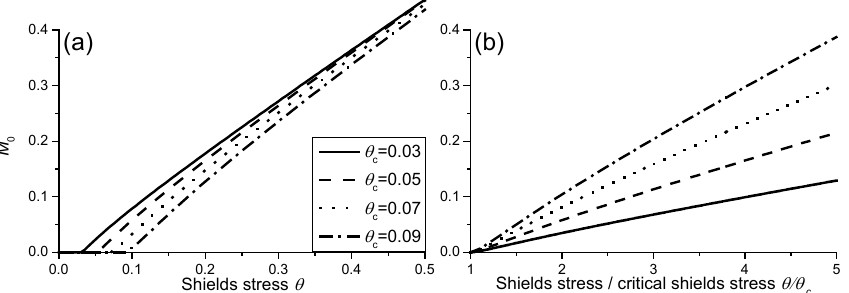
depicted as a function of (a) the Shields stress and (b) the ratio of Shields stress to 0